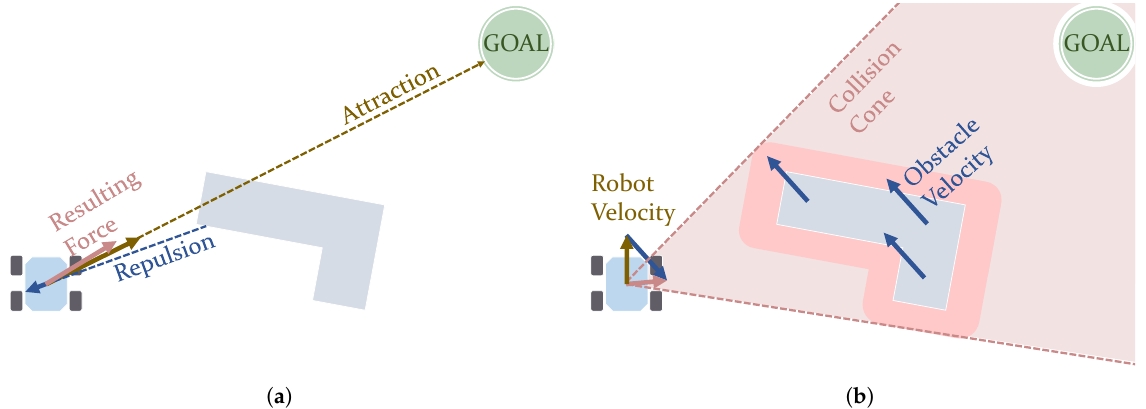
Figure 5. Graphical representations of concepts used in Artificial Potential Field ( a ) and Velocity Obstacle ( b ) algorithms. ( a ) Potential fields acting on a robot. ( b ) Collision cone considering a moving obstacle.